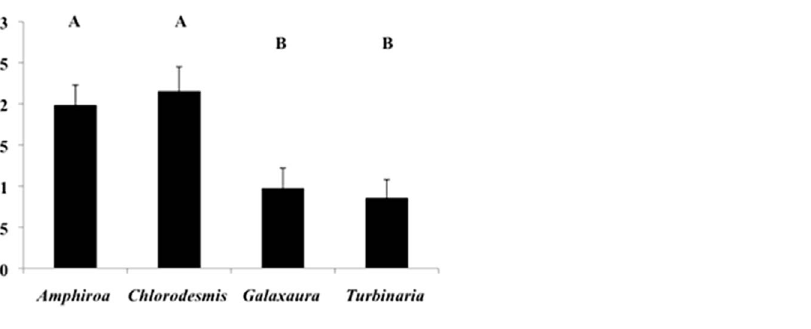
Fig. 5. Mean gene expression (spot intensity) of all differentially expressed coral and Symbiodinium genes (combined) grouped by macroalgal treatment (ANOVA; P 5 0.0003). Letters indicate significant groupings by Tukey-Kramer HSD post-hoc